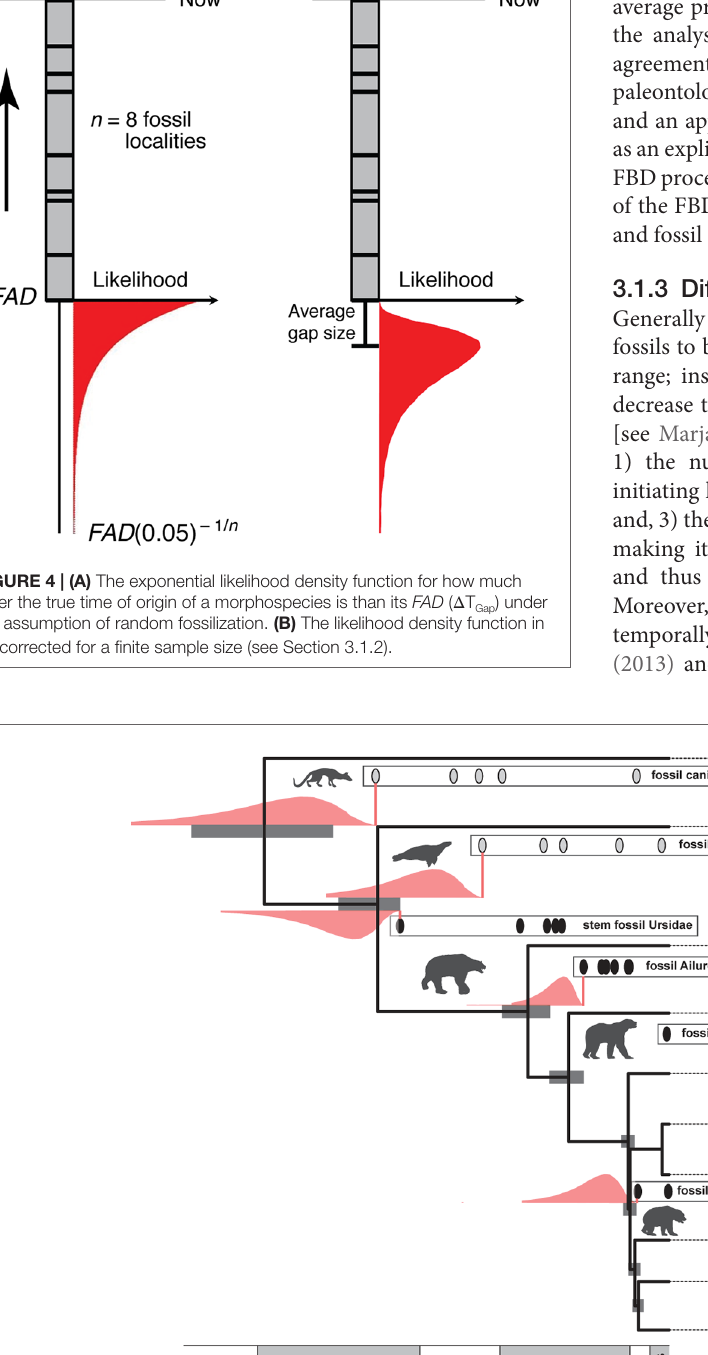
Frontiers in Genetics |